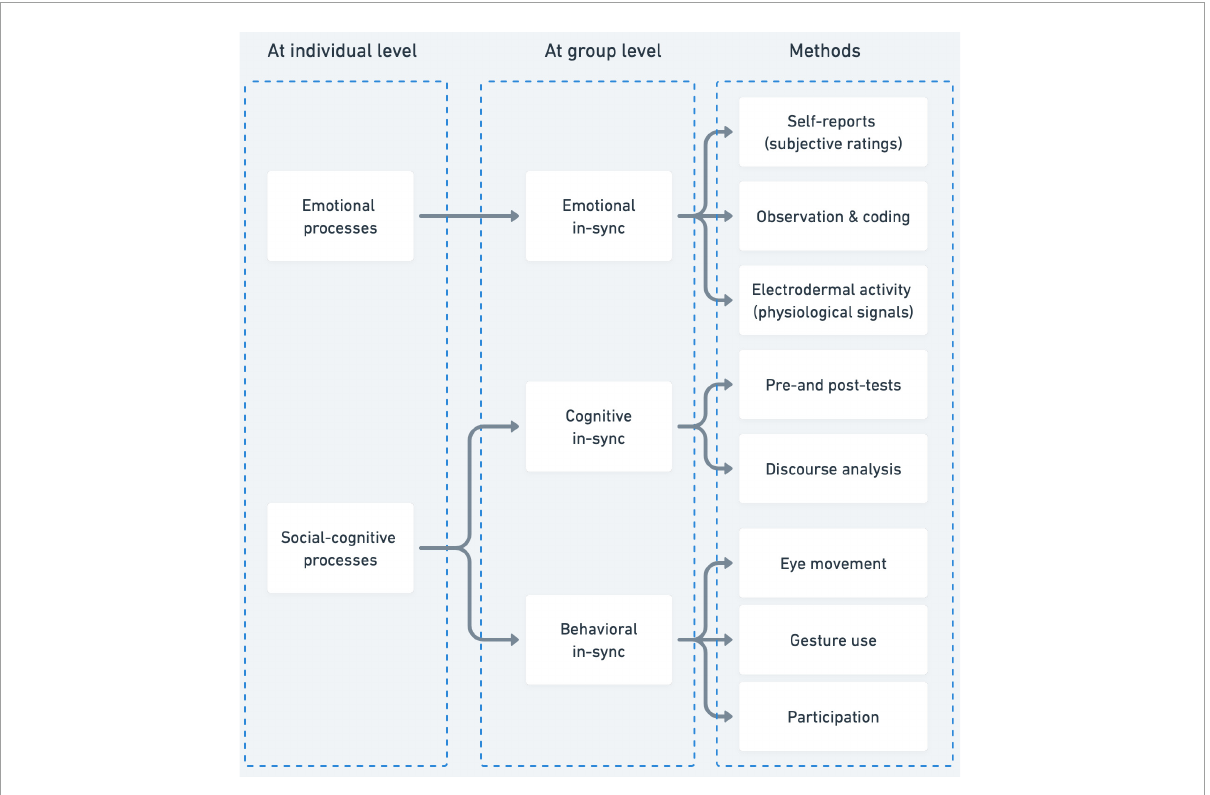
FIGURE1 A visualization of the multimodal